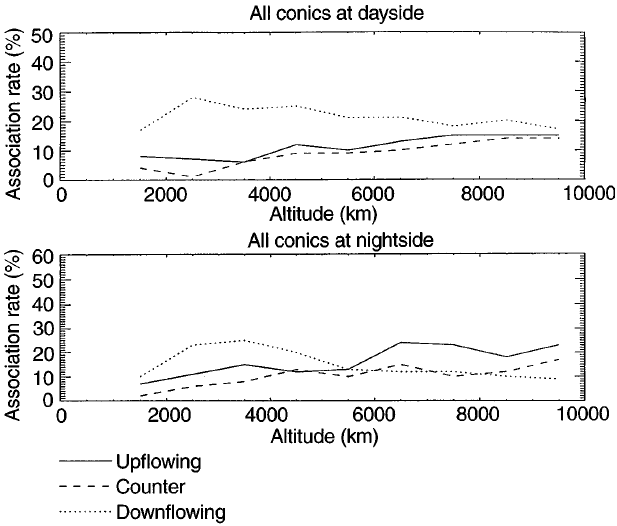
Fig. 7. Altitude variation of the association rate of the three types of field-aligned electron beams with